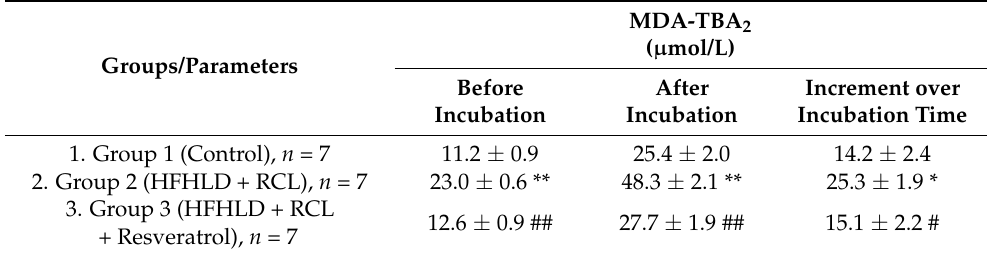
Table 3. Effects of resveratrol on lipid peroxidation (LPO) in the blood of rats fed a high-fructose high-lipid diet (HFHLD) under round-the-clock lighting (RCL).